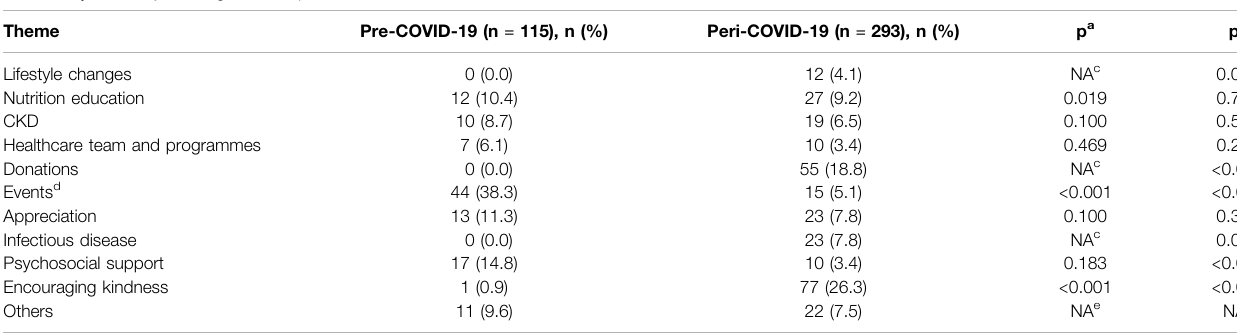
TABLE 2 | Summary of assignment of posts to the